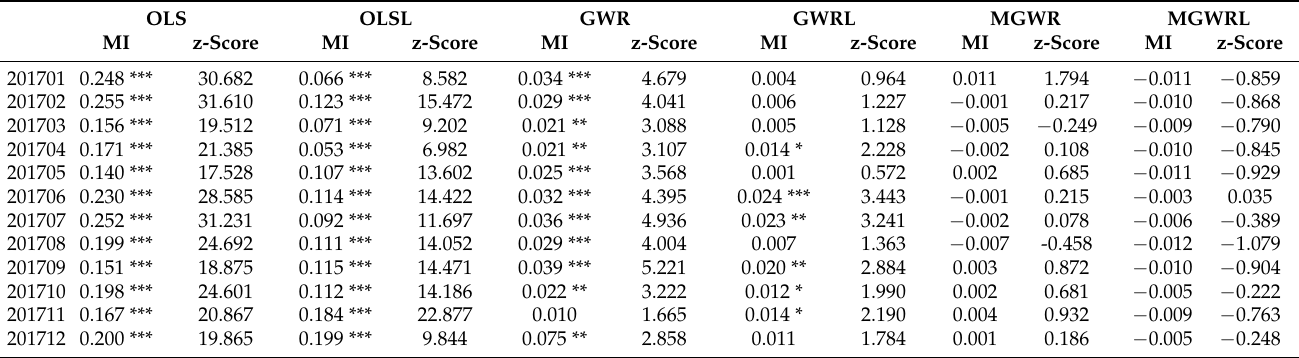
Table 3. Moran’s I of residuals (MI = Moran’s I